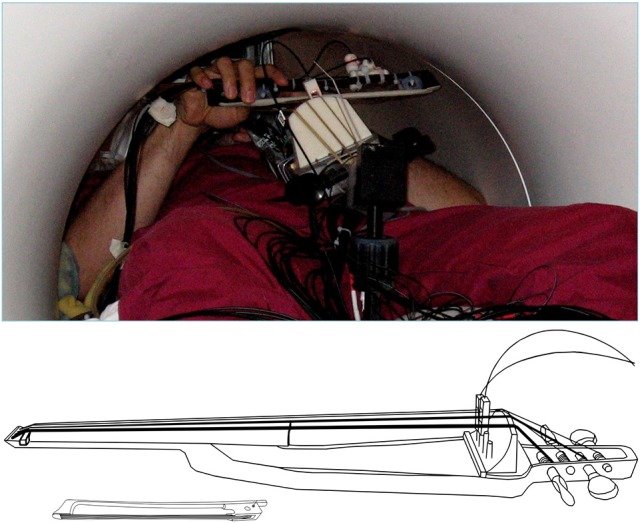
(Top) View of the MR-compatible cello and bow inside the scanner during experiment. (Bottom) Line drawing of cello and bow developed for use inside the MR Scanner. Cello fingerboard has the same dimensions as a fullsized cello to preserve the location and spacing of notes. Optic sensors at the bridge are used to detect string vibrations, and are converted to analog audio output by a custom ARM board (not shown). The MR Compatible bow is 20 cm long, which is just under a third of the length of a typical cello bow (approximately 70 cm).